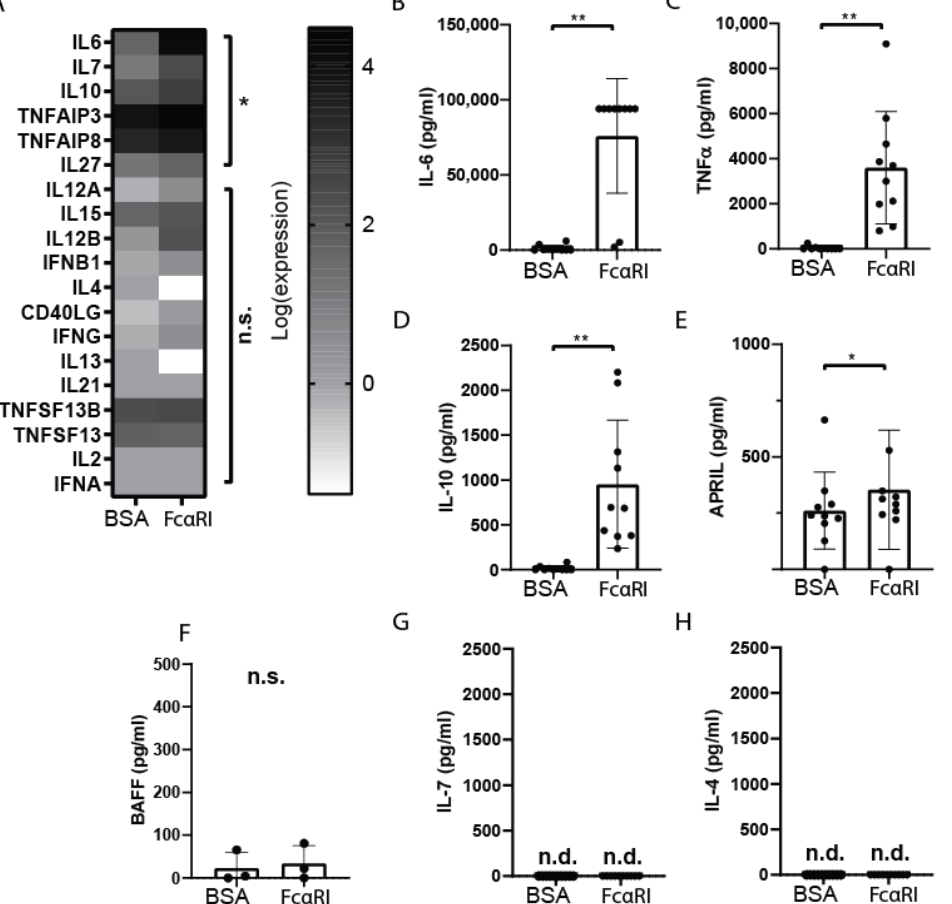
Figure 3. Fc α RI-stimulated monocytes produce interleukin-6, interleukin-10, and tumor necrosis factor- α . Human peripheral monocytes were cultured with BSA- or IgA-coated (activating Fc α RI) beads for 4 h. ( A ) Heat map of log-transformed RNA-seq counts of human peripheral monocytes stimulated with BSA- ( n = 5) or IgA-coated (activating Fc α RI) ( n = 10) beads. Genes above an lfdr of 0.05 are considered significant. Coloring represents log expression of the expressed genes. Peripheral monocytes were cultured with BSA- ( n = 10) or IgA-coated (activating Fc α RI) ( n = 10) beads ( n = 10) for 24 h. Luminex was performed on supernatant of stimulated monocytes to determine ( B ) interleukin-6, ( C ) tumor necrosis factor- α (TNF α ), ( D ) interleukin-10, ( E ) APRIL, ( G ) interleukin-7, and ( H ) interleukin-4 secretion. ( F ) Similarly, BAFF secretion was measured 24 h after BSA- or IgA-coated (activating Fc α RI) bead stimulation ( n = 3) using ELISA. Not detected protein (n.d.) is represented as zero. Data are presented as the mean ± SD. n.s.= not significant. Wilcoxon matched rank test, * p < 0.05, ** p < 0.01.